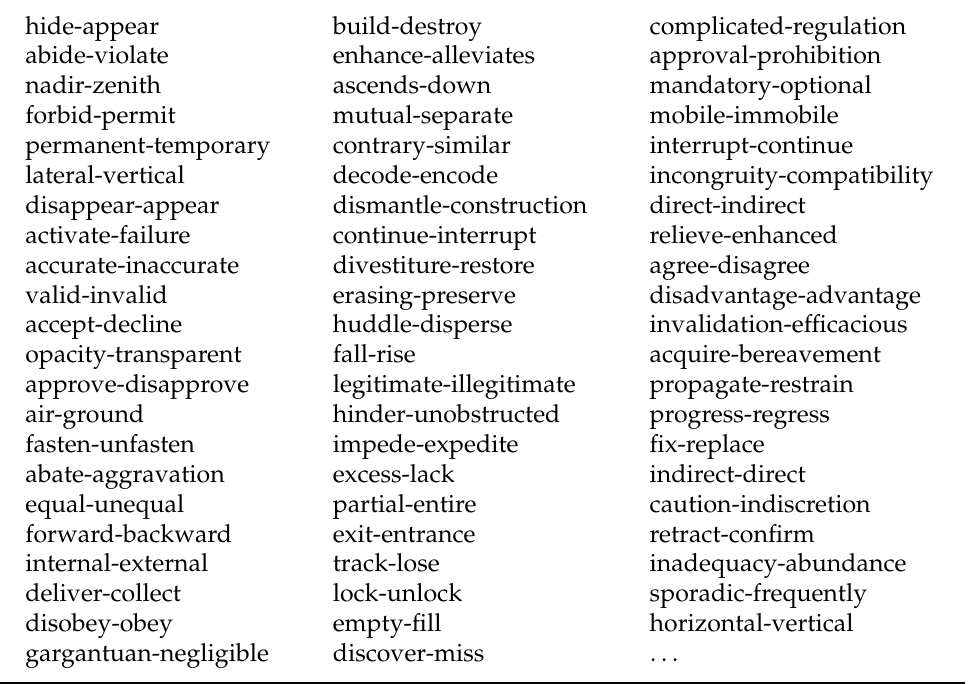
Table 1. The antonyms in the antonym